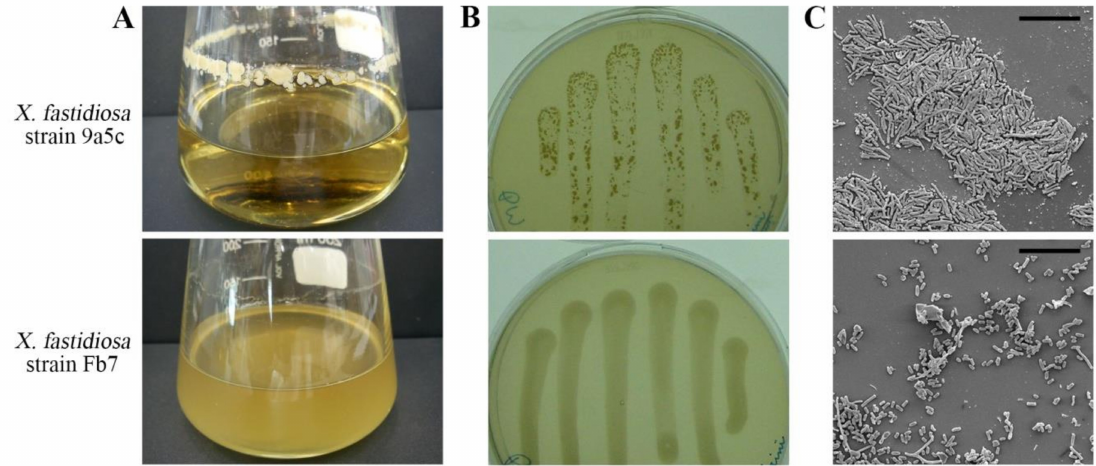
Figure 1. Comparison of aggregation and biofilm formation phenotypes of Xylella fastidiosa strains 9a5c and Fb7. ( A ) The reference strain 9a5c forms large aggregates and compact biofilm structures, while strain Fb7 remains mostly planktonic and forms very little biofilm on glass under agitation. ( B ) Cellular suspensions spotted on PW agar plates and drained to the other side of the plates forming the columns also show a distinct biofilm formation between the strains after 7 days of growth, with a wax-like texture for 9a5c and a gum-like texture for Fb7. ( C ) Scanning electron micrographs of glass coverslips observed after 3 days in bacterial cultures show the distinct aggregation behavior between the strains at the cellular level. Scale bar is 10 µ m for both